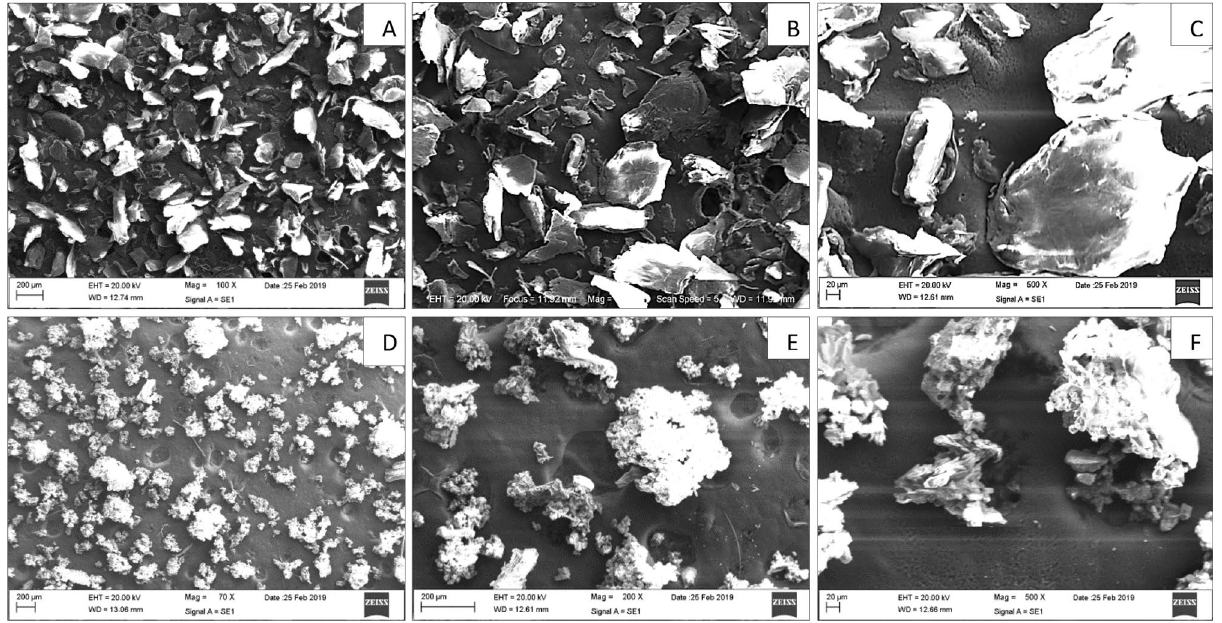
Figure 2. Scanning electron microscope (SEM) images of chitosan; ( A – C ) FC 100×, 200×, 500× ( D – F ) PC 100×, 200×,